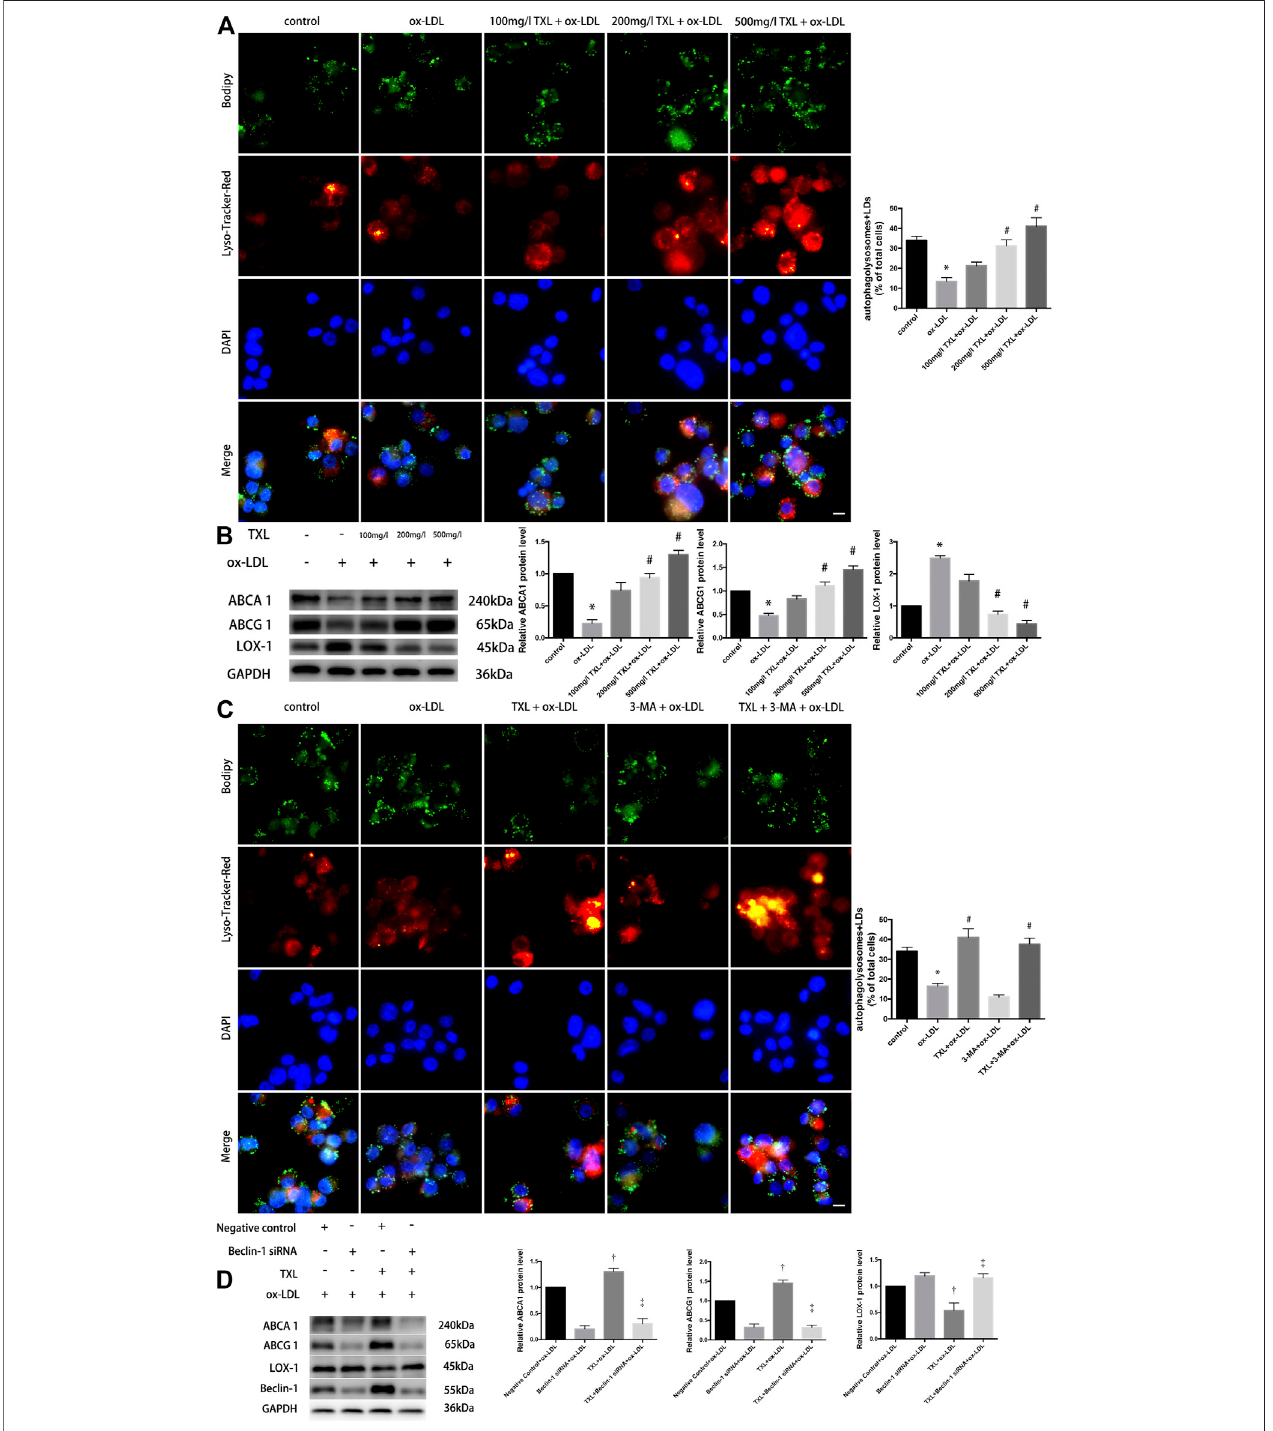
FIGURE 3 | TXL treatment reduced lipid deposition by increasing autophagy in THP-1 Macrophages. (A) Effects of TXL on intracellular lipid metabolism of macrophages mediated by autophagy, n (cid:2) 3, bar (cid:2) 10 μ m, * p < 0.05 vs. control, # p < 0.05 vs. ox-LDL. (B) Western Blot detection of TXL on ox-LDL-induced macrophage lipid ef fl ux, n (cid:2) 3, * p < 0.05 vs. control, # p < 0.05 vs. ox-LDL. (C) Detection of autophagy in TXL inhibited ox-LDL-induced macrophage lipid deposition via cellularimmuno fl uorescence, n (cid:2) 3,bar (cid:2) 10 μ m,* p < 0.05vs.control, # p < 0.05vs.ox-LDL. (D) WesternblotrevealedtheeffectofBeclin-1ininhibitionofox-LDL- induced lipid deposition in TXL-treated macrophages. n (cid:2) 5, † p < 0.05 vs. Negative control + ox-LDL, ‡ p < 0.05 vs. TXL + ox-LDL.